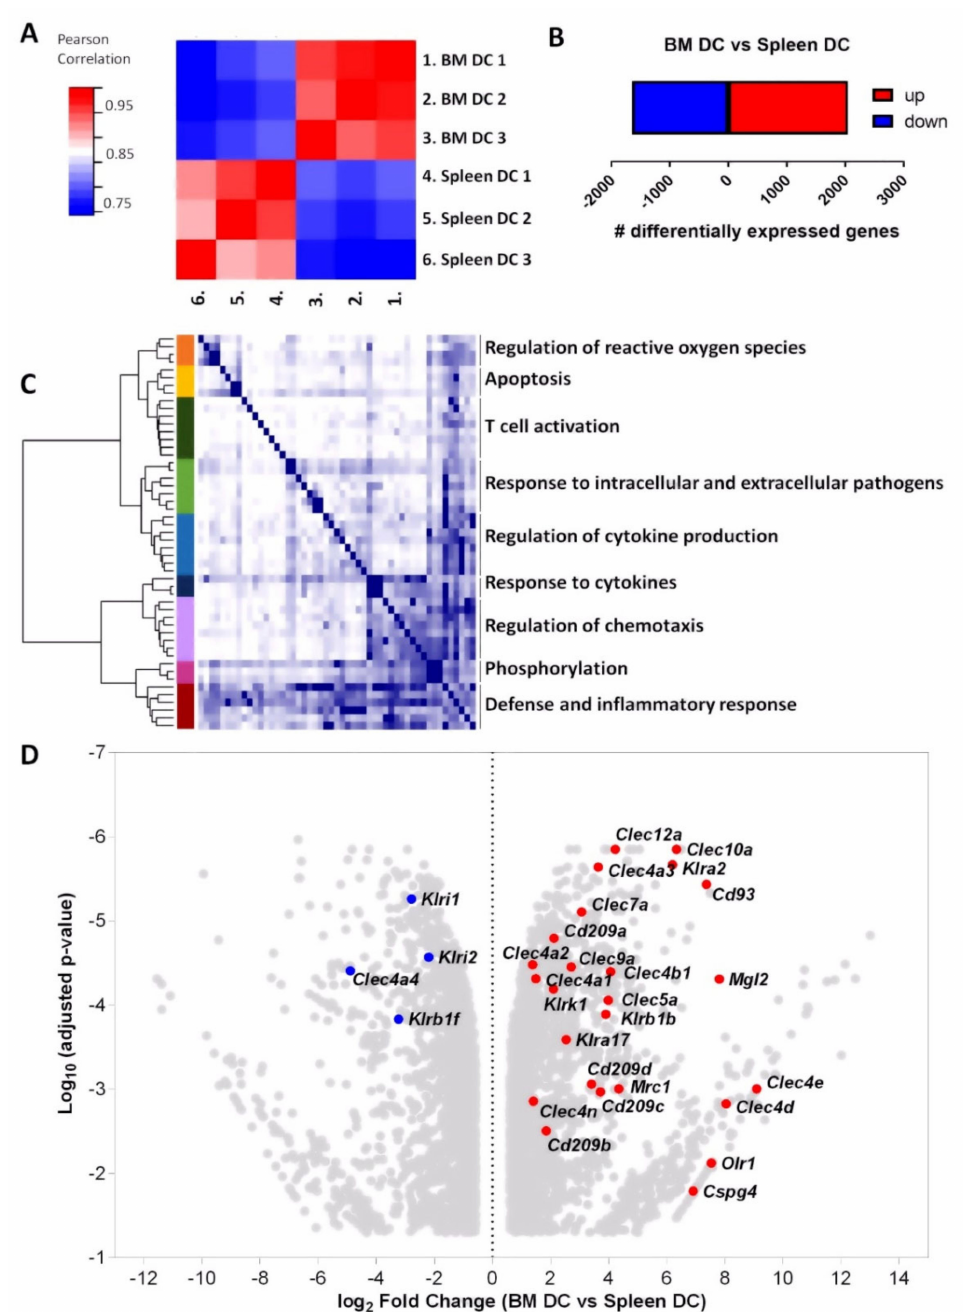
Figure 2. mRNA profiling reveals high expression of c-type lectin family receptors by BM DCs. RNAseq analysis was performed on cDC2 derived from BM and spleen. ( A ) Hierarchical clustering of the samples based on Pearson’s correlation coefficient. ( B ) Bar plot showing a total of 3697 differ- entially expressed (DE) genes being significantly up- (red, 2052) or downregulated (blue, 1645) in BM cDC2 as compared to splenic cDC2. ( C ) Hierarchical clustering of gene ontology (GO)-terms enriched in the DE expressed genes. In total 51 GO-terms were found enriched, which we clustered into 8 groups by comparison of their overlap index. Results are shown as a heatmap of the overlap indices, with the clustering and a color representation of each group on the left and a short description of the group on the right. The full heatmap is shown in Supplementary Figure S2. ( D ) Volcano plot of significantly up- and downregulated genes. Colored dots indicate genes encoding CTL/CTLD super- family receptors being significantly up- (red) and downregulated (blue) in BM cDC2 as compared to splenic